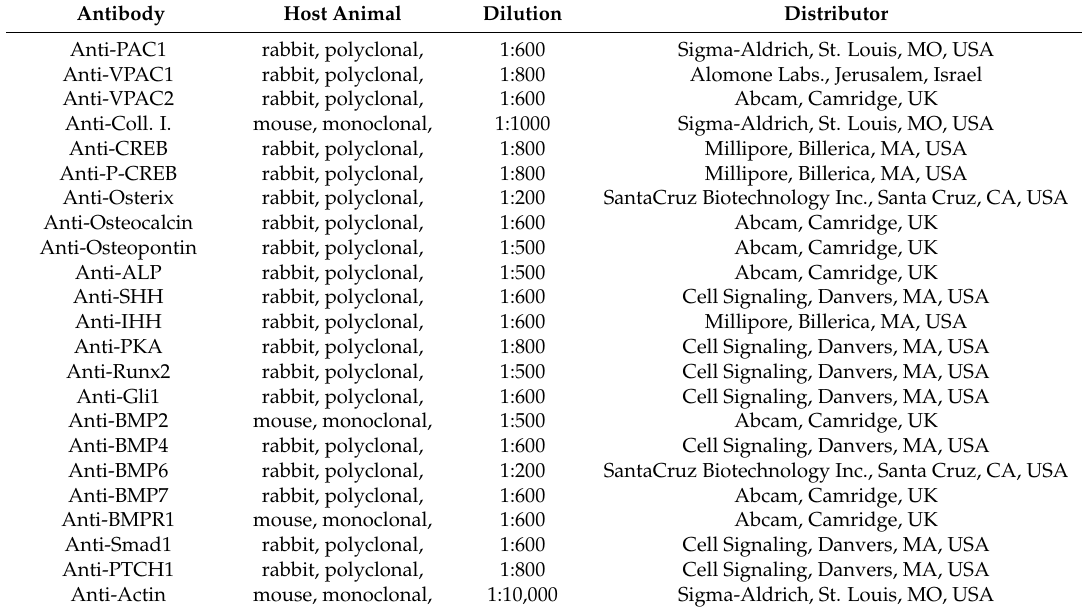
Table 2. Tables of antibodies used in the